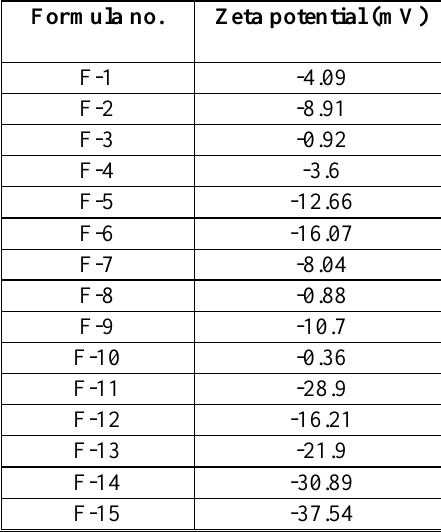
Table 7. Zeta potential values of CC SEDDS formulations.